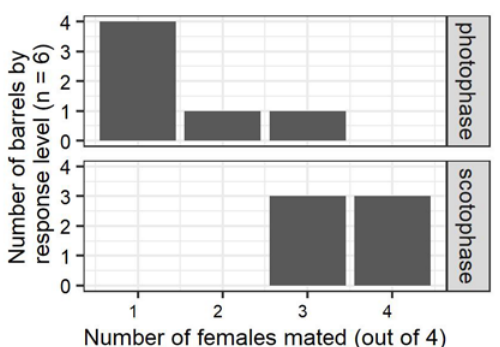
Figure 2. Proportion of females mated in 208 L chambers when treatment 5 (no mating disruption, see Figure 1) was performed during the photophase (above) and the scotophase (below). There was a significantly higher proportion of females mated when paired in scotophase than when paired in photophase (Fisher’s exact test, n = 12, p = 0.03).